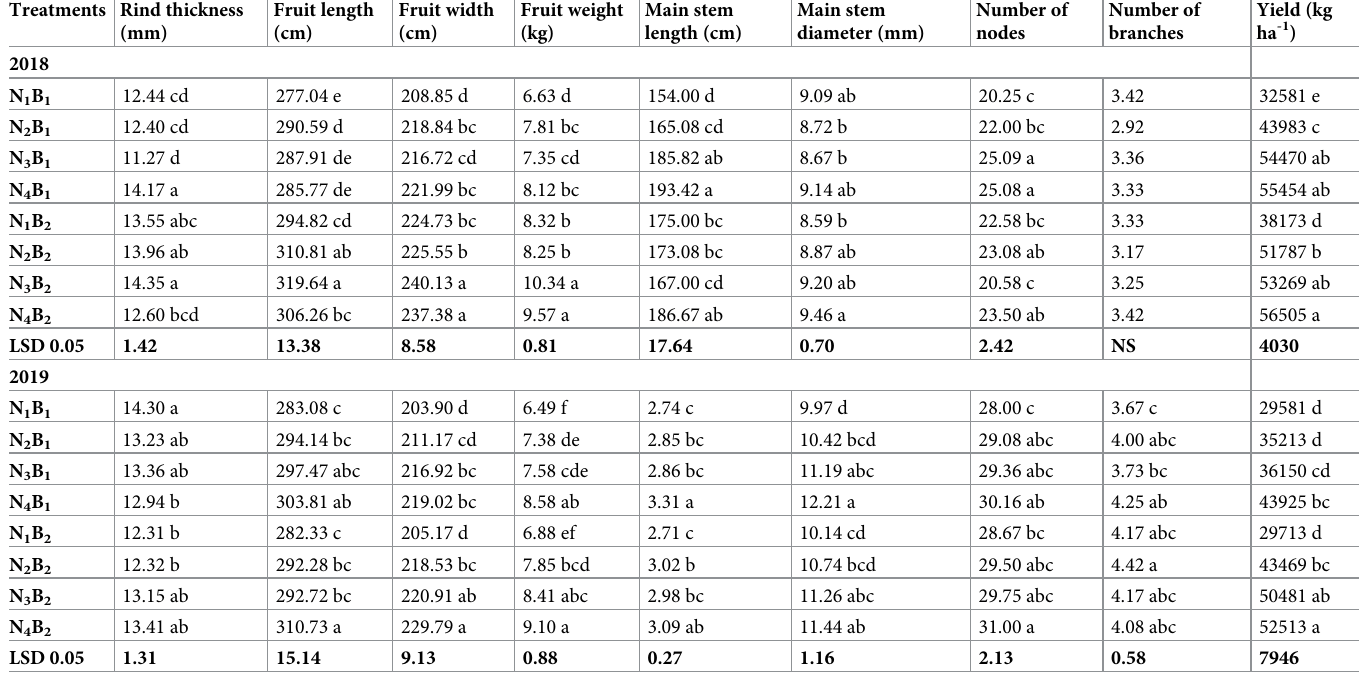
Table 3. The interactive effect of different nitrogen and boron doses on the pomological attributes of grafted watermelon grown under climatic conditions of C¸ukurova region. Treatments Rind thickness Fruit length Fruit width Fruit weight (mm) (cm) (cm)